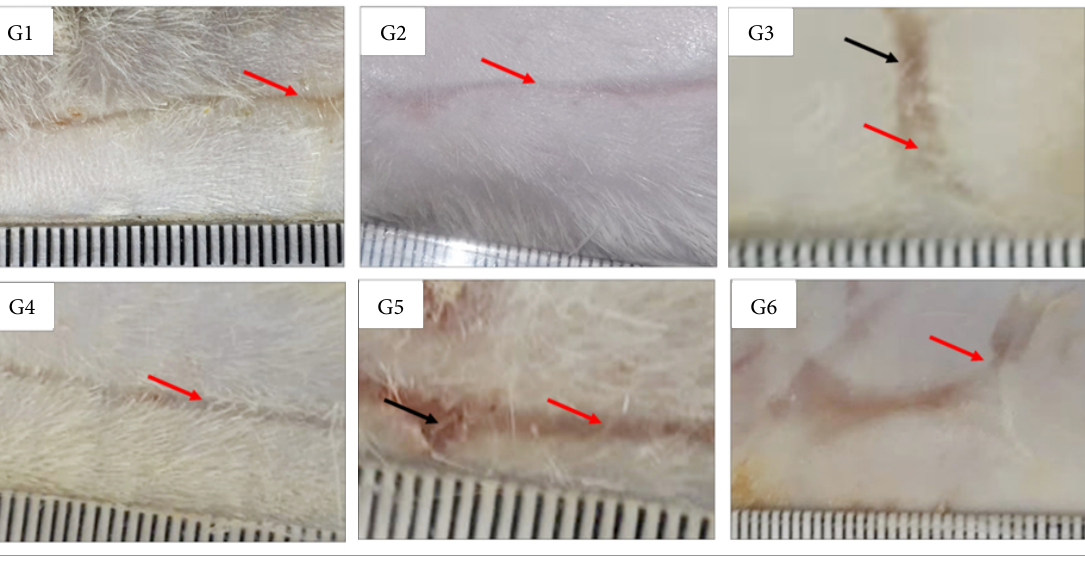
Figure 3 - Macroscopic aspects of partial thickness burn wounds experimentally induced in Wistar rats 30 days after the injury induction. Scale in